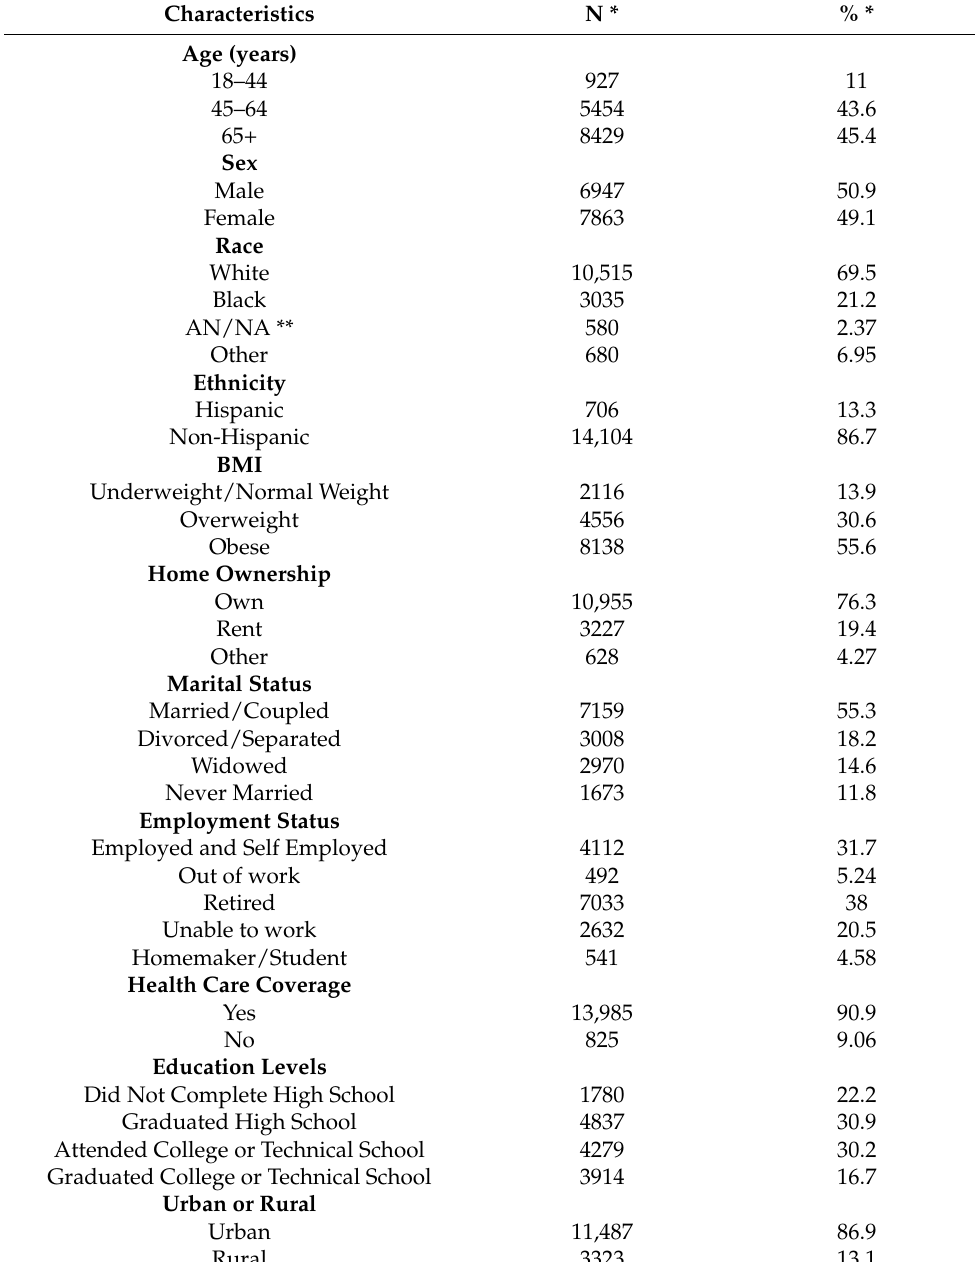
Table 1. Baseline characteristics of the study